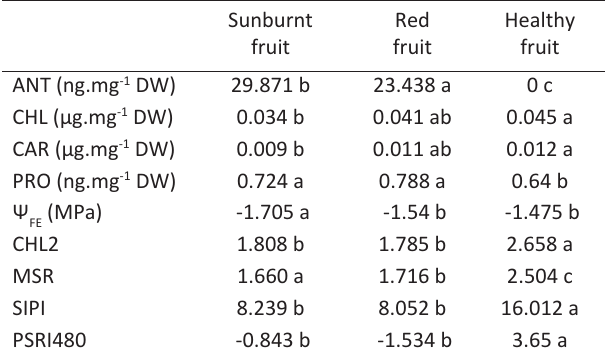
Table 2 ­ Median of anthocyanins (ANT), Chlorophyll (CHL), Carotenoids (CAR) and proline (PRO) concentration, hydric potential of the exposed side of the fruit (ѰFE), Reflectance Ratio (CHL2), Chlorophyll concentration estimate by reflectance (MSR, Modified Spectral Ratio), Structural Independent Pigment Index (SIPI) and Plant Senescence Reflectance Index (PSRI480), for the three types of fruit (healthy fruit, sunburnt fruit, and red fruit) Sunburnt fruit fruit